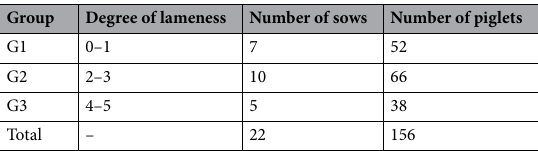
Table 3. The number (n) of sows and piglets studied per group.